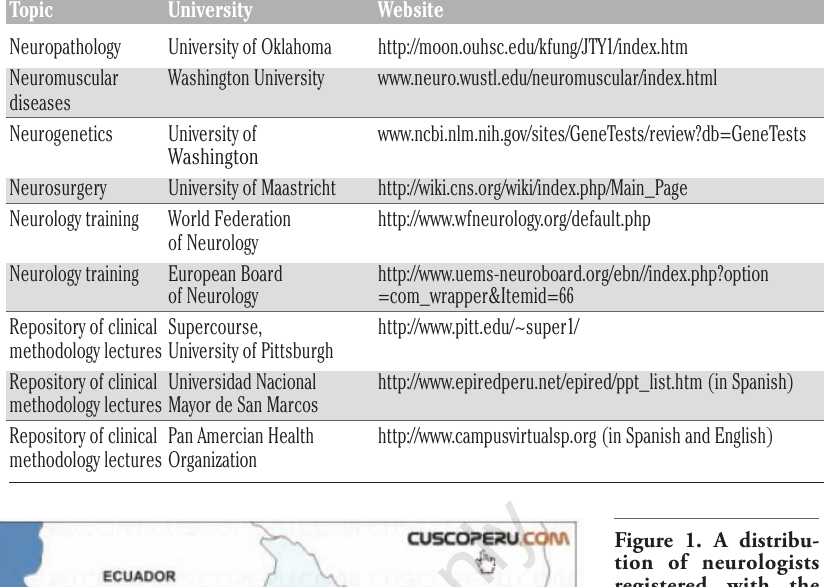
Figure 1. A distribu- tion of neurologists registered with the Peruvian Medical